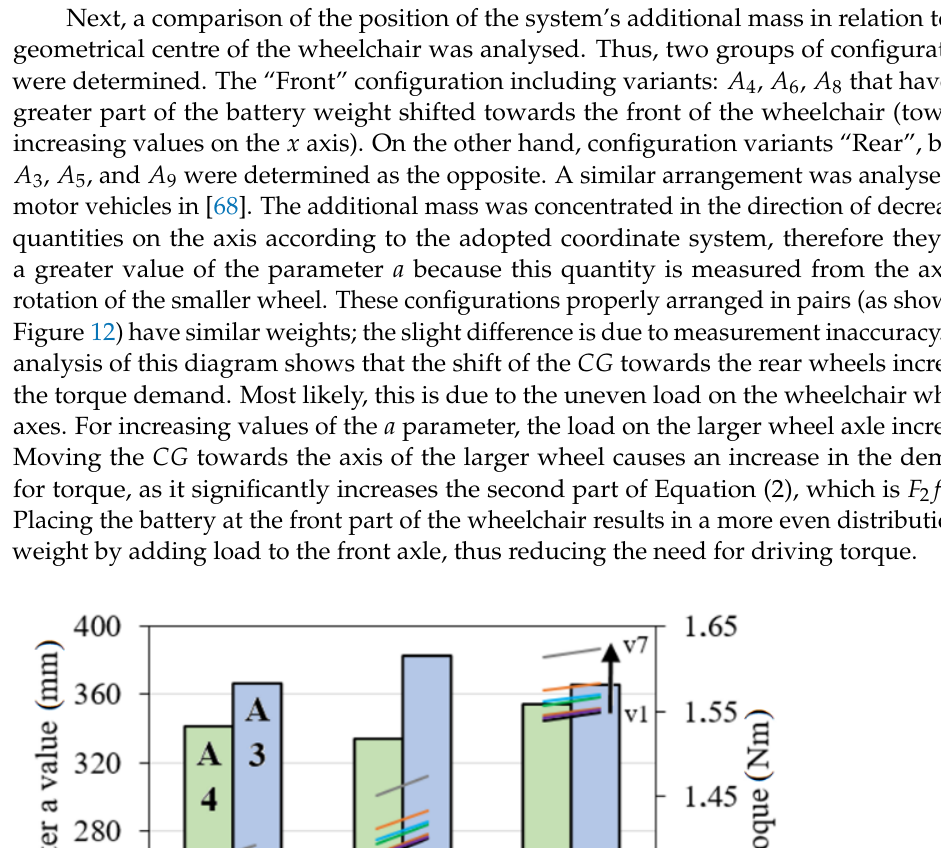
Figure 11. Parameter a position; ( a ) in relation to work time coverage, ( b ) in relation to torque demand.